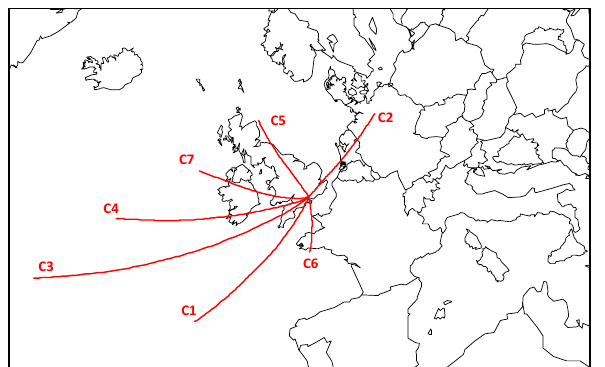
Fig. 5. Final centres of 7 clusters (K-mean partitioning method) of backward trajectories finishing at Harwell during the 2006–2010